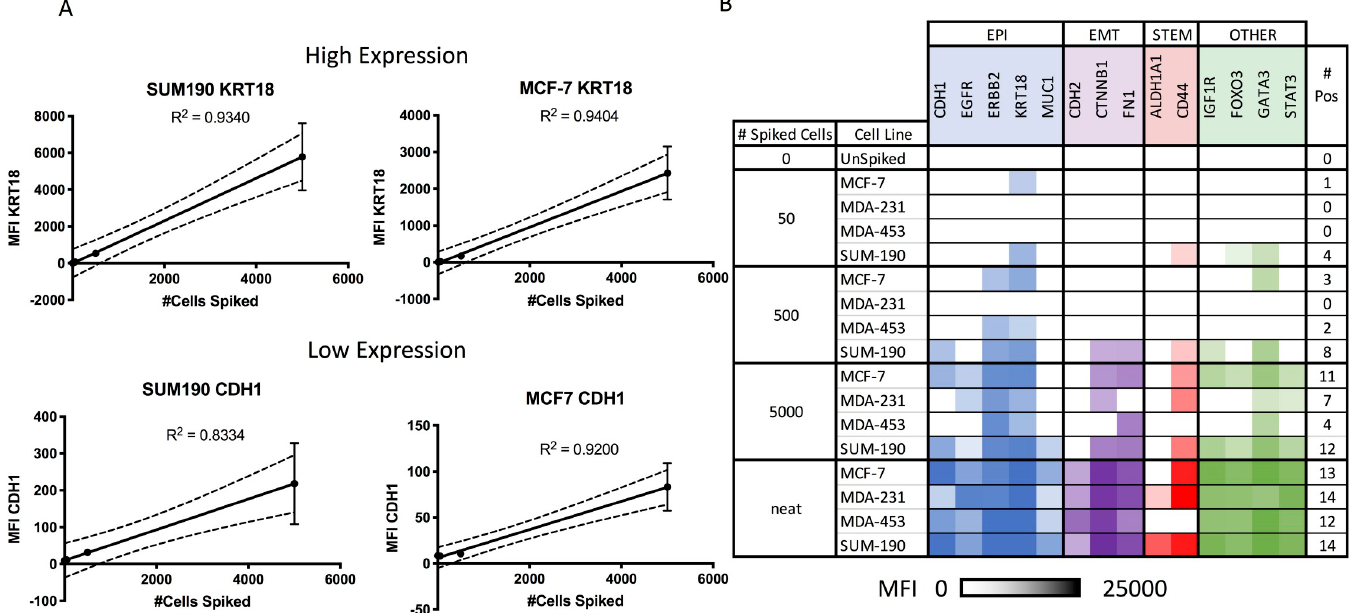
PLOS ONE | https://doi.org/10.1371/journal.pone.0241123 October 23,